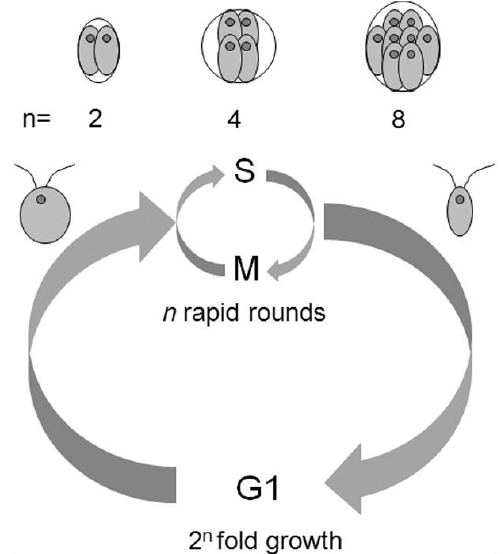
Figure 1. Schema of the C. reinhardtii cell cycle. A very long G1 phase is followed by a series of n rapid alternating rounds of S and M phase yielding 2 n daughter cells. The value of n is related to the extent of growth during the G1 phase. Divided mother cells with di ff erent numbers of divisions ( n ) and daughter cells produced are schematically drawn on the top (modified after